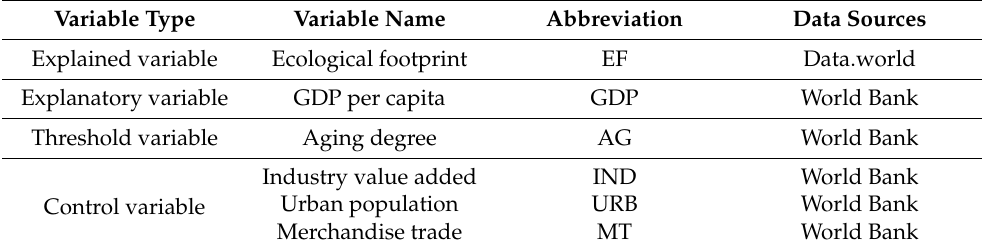
Table 1. Variable definition and data